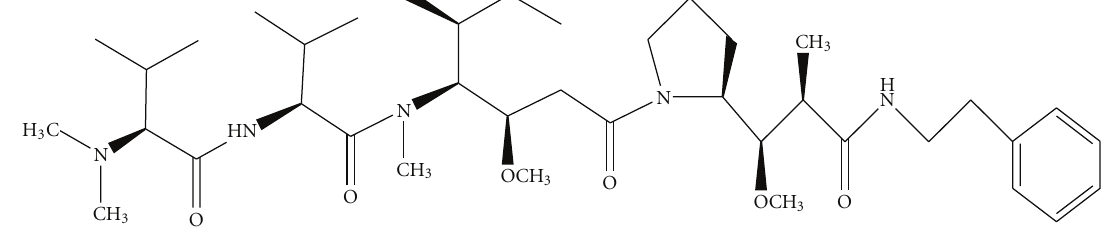
Figure 4: Structure of TZT-1027.